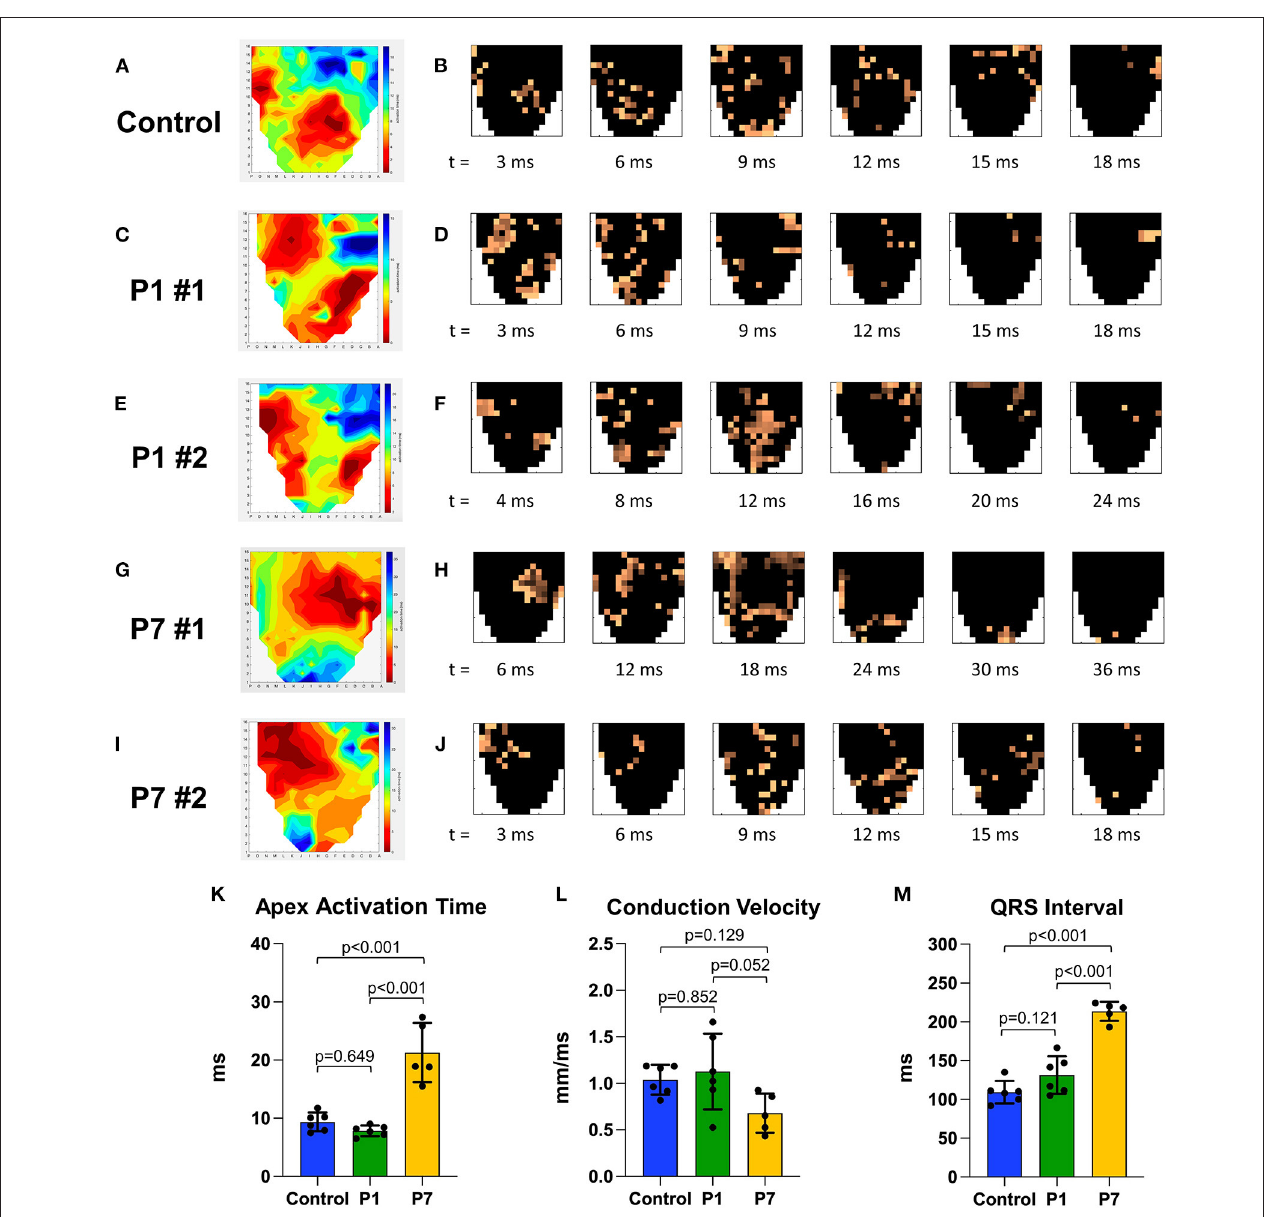
FIGURE 4 | Piglets demonstrate conserved epicardial conduction dynamics after myocardial infarction on postnatal day 1. At 7 weeks after myocardial infarction (MI), epicardial conduction mapping was performed. Representative isochrone activation maps and timelapse activation maps are presented for (A,B) one healthy control, illustrating normal conduction through the right and left bundle branches and Purkinje system; (C–F) two pigs receiving MI on postnatal day 1 (P1) with similar activation patterns as healthy controls; and (G–J) two pigs receiving MI on postnatal day 7 (P7), including (G,H) one P7 pig which developed right bundle branch block, and (I,J) one P7 pig which developed left bundle branch block. (K) Apex activation time was similar between controls and P1 pigs, but profoundly delayed in P7 pigs. (L) Conduction velocity was similar between controls and P1 pigs, but slower in P7 pigs. (M) QRS interval was similar between controls and P1 pigs, but significantly longer in P7